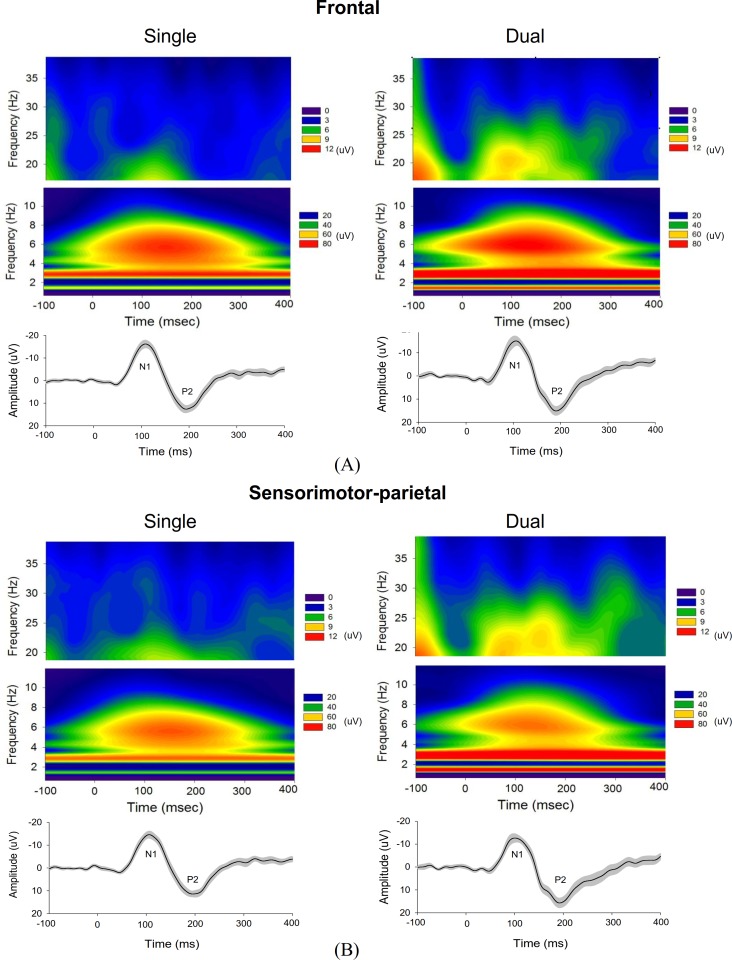
Principal components (PC) of the ERP for the single-posture and dual-task conditions.(A) and (B) represent ERP PC analysis in the frontal and sensorimotor-parietal areas, respectively. The upper and middle rows represent the pooled time-frequency distribution of PC1 (the primary principal component of ERP in the regions of interest) in the 13–35 Hz and 1–12 Hz spectral bands, respectively. The bottom row is the mean temporal profile of ERP PC1, which clearly exhibits N1 and P2 components.